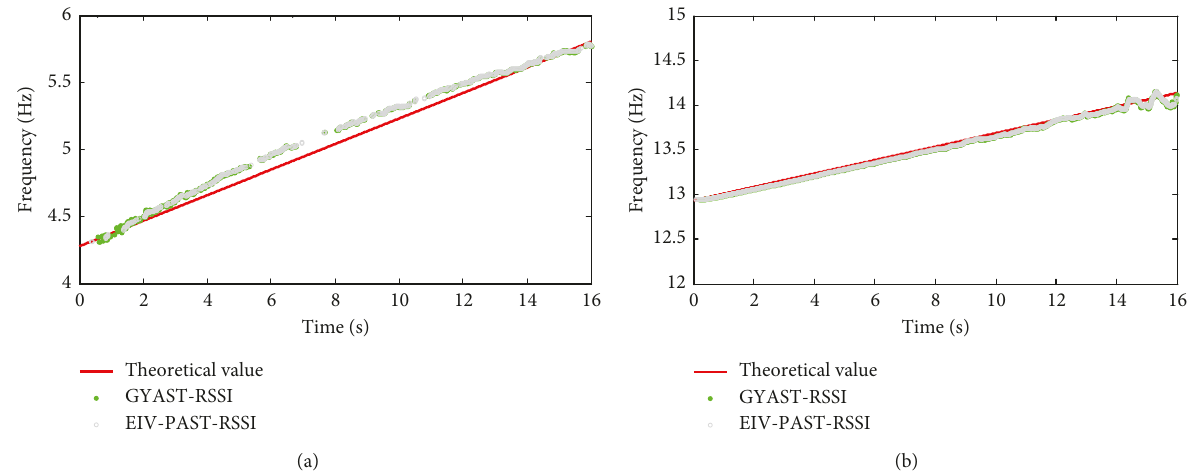
Figure 10: Frequency identification results of the first two modes using different methods for simulation case 2 (SNR (b) mode 2.